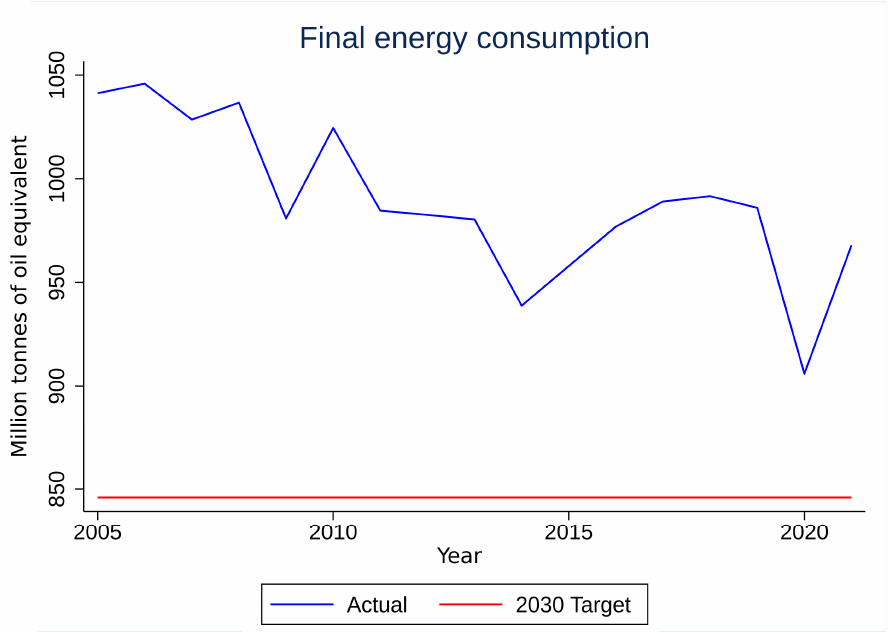
Figure 4. European Union’s final energy consumption with regard to 2030 goals. Source: Own elaboration based on public data available at EuroStat. The data were accessed on 4 February 2022 from https://ec.europa.eu/eurostat/web/main/data/database.